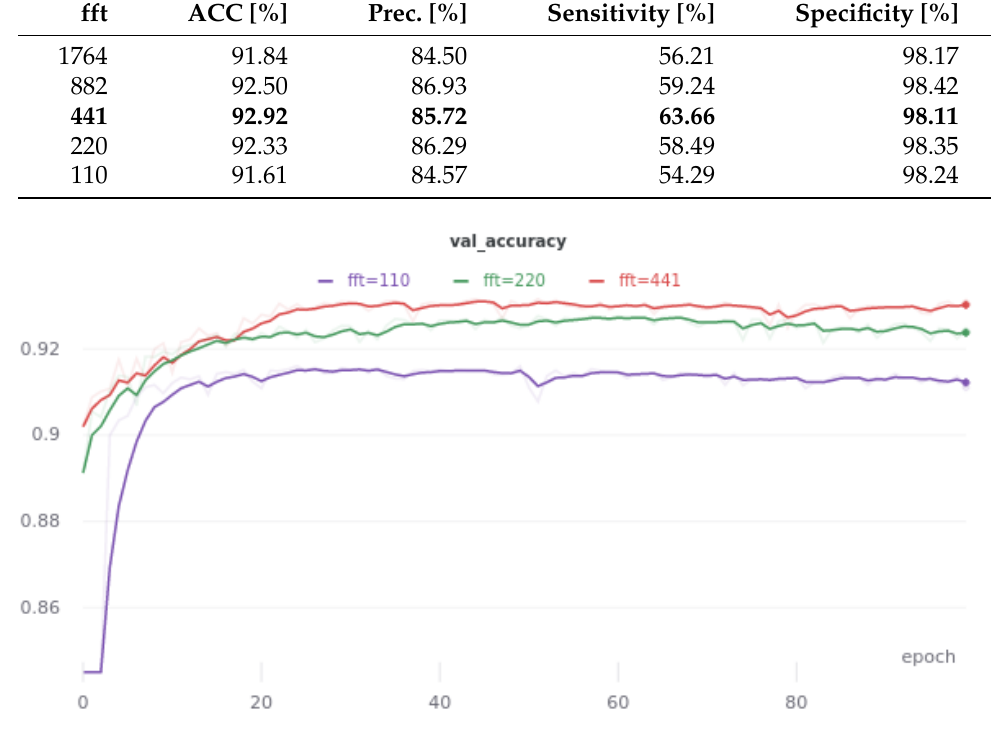
Figure 3. Smoothed learning curves representing the accuracy of the linking model on the validation set, depending on the window width fft for 3 different